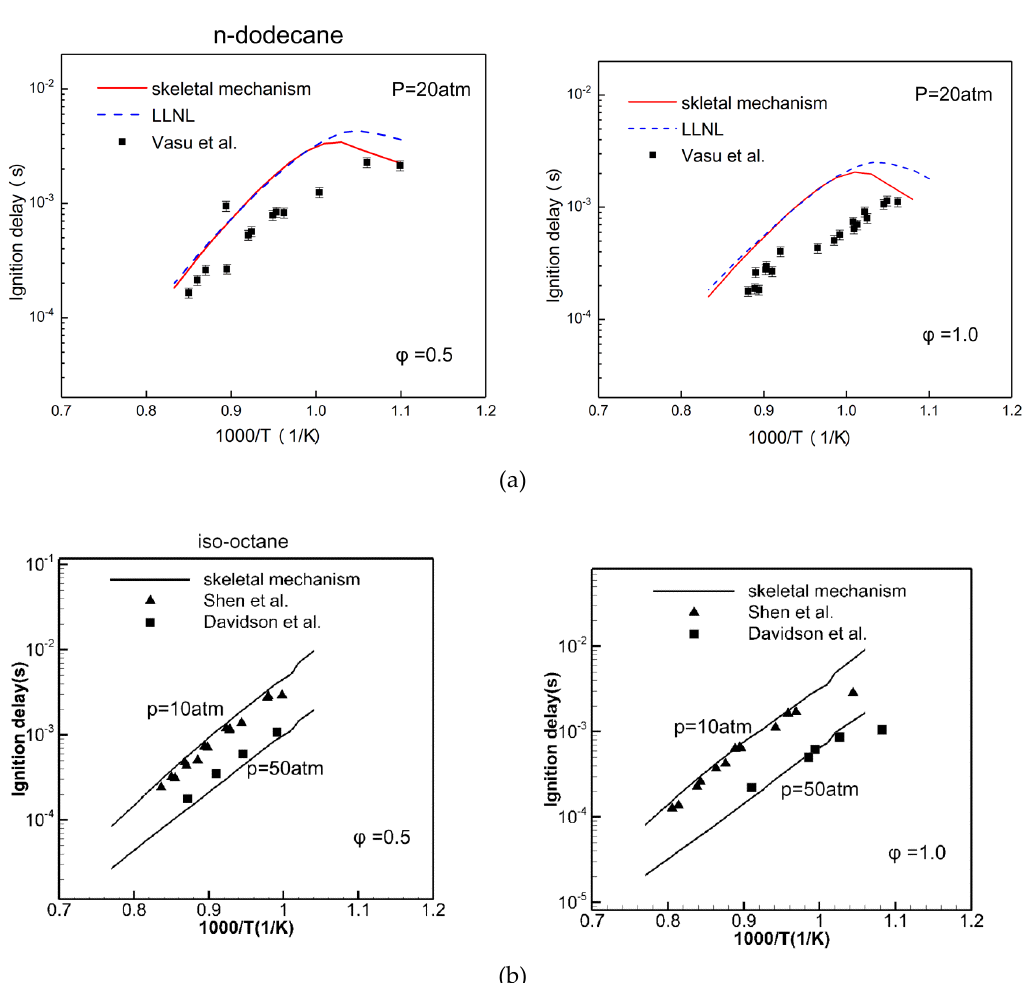
Figure 6. Comparison of simulation (line) and measured (symbol) [23–25] ignition delay in shock tubes with (a) n-dodecane and (b) iso-octane.